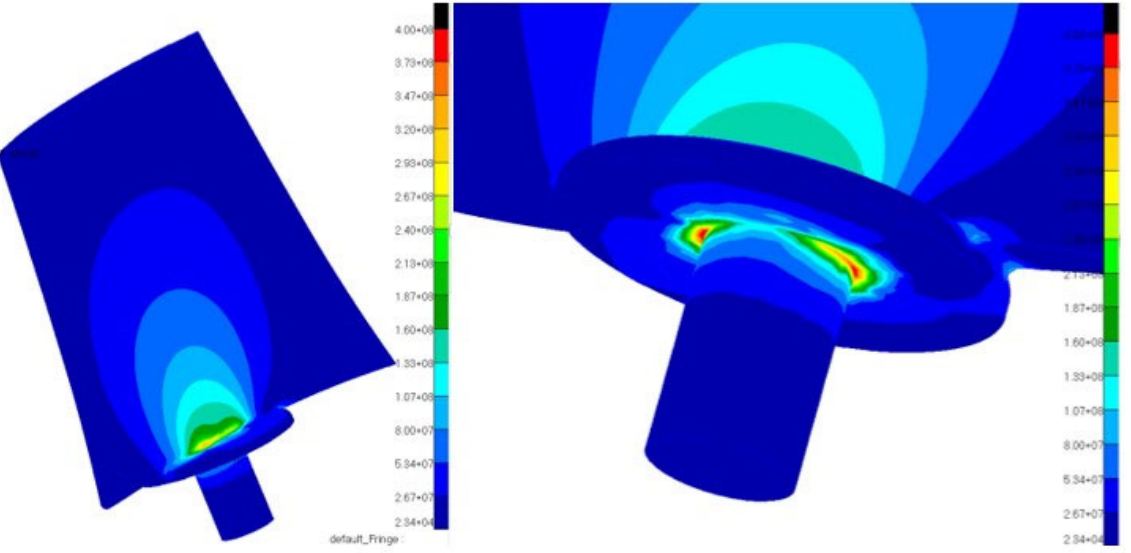
Figure 11. Reduced stress map of the blade. The maximum values reach 400 MPa.